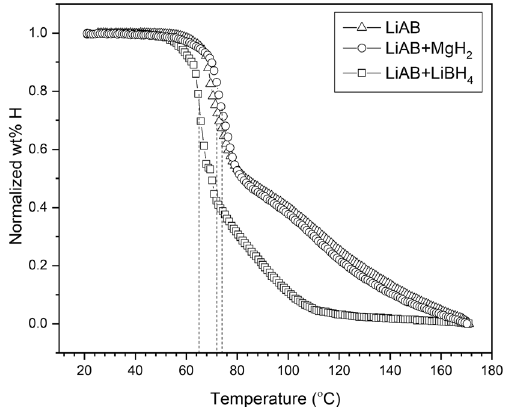
Fig. 3 Dynamic thermal decomposition of LiNH 2 BH 3 + MgH 2 (open circle), LiNH 2 BH 3 + LiBH 4 (open square), and pure LiNH 2 BH 3 (open triangle) under 1 bar hydrogen pressure (heating rate 1 °C min −1 in Sievert apparatus)